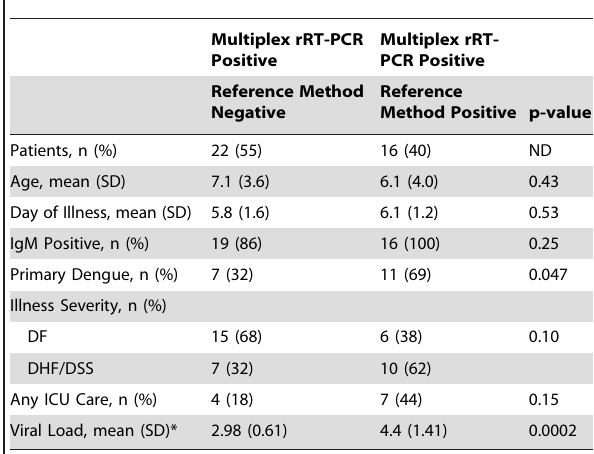
Figure S1 STAndards for the Reporting of Diagnostic accuracy studies (STARD) flowchart.